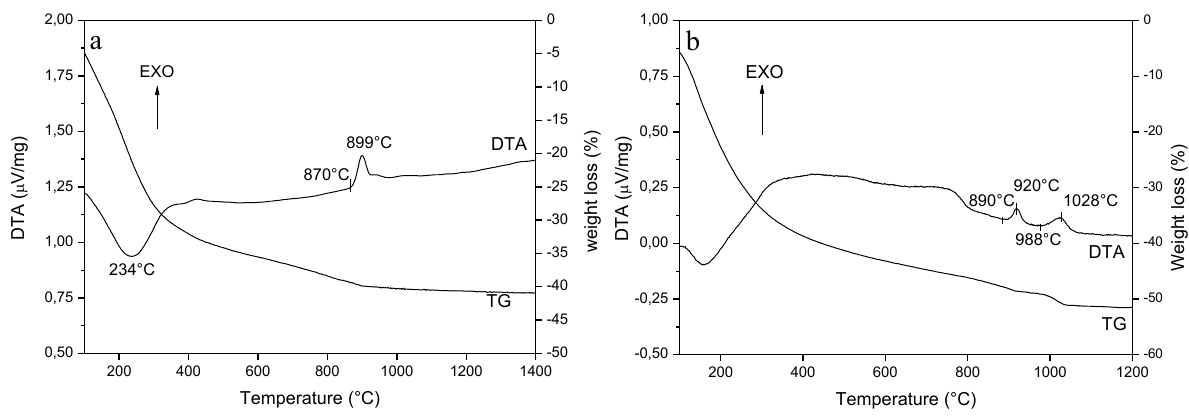
Figure 2. DTA-TG curves of ( a ) YAG cl -AA and ( b ) YAG cl